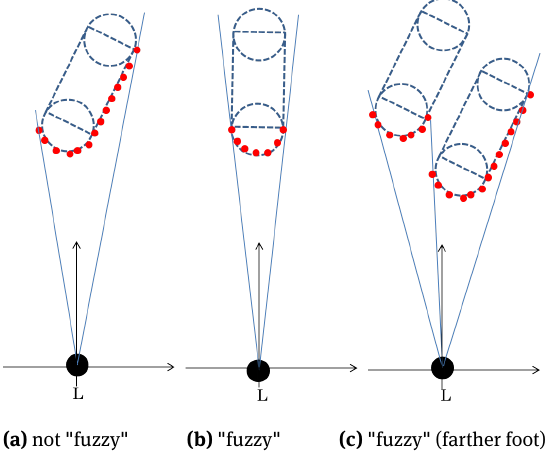
Fig. 9. Different Situation in Foot Detection